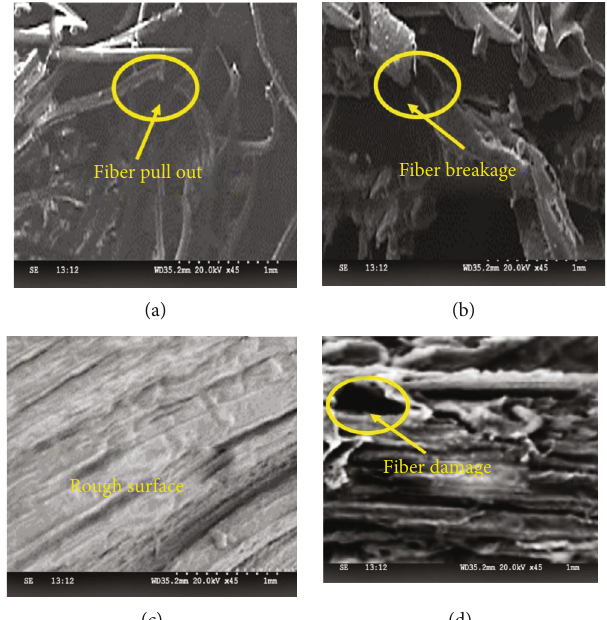
Figure 12: Microstructural analysis of (a) untreated, (b) 2 hrs NaOCl treated, (c) 4 hrs NaOCl treated, and (d) 6hrs NaOCl treated fi